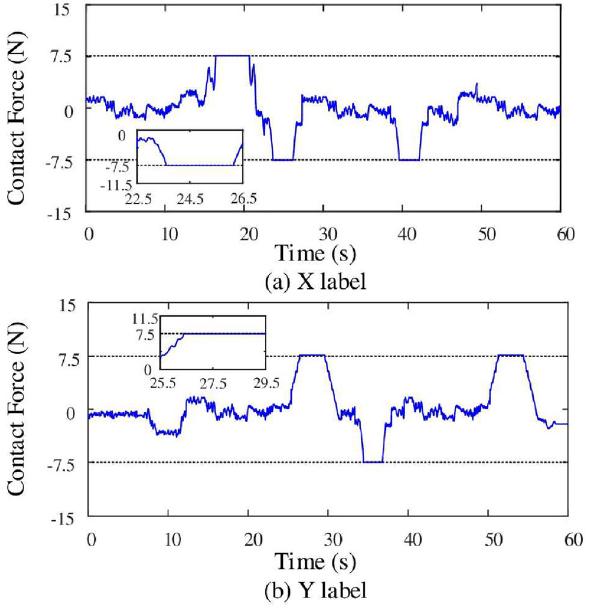
Fig. 18 Human–robot interaction contact force curves under proposed decentralized robust interaction control